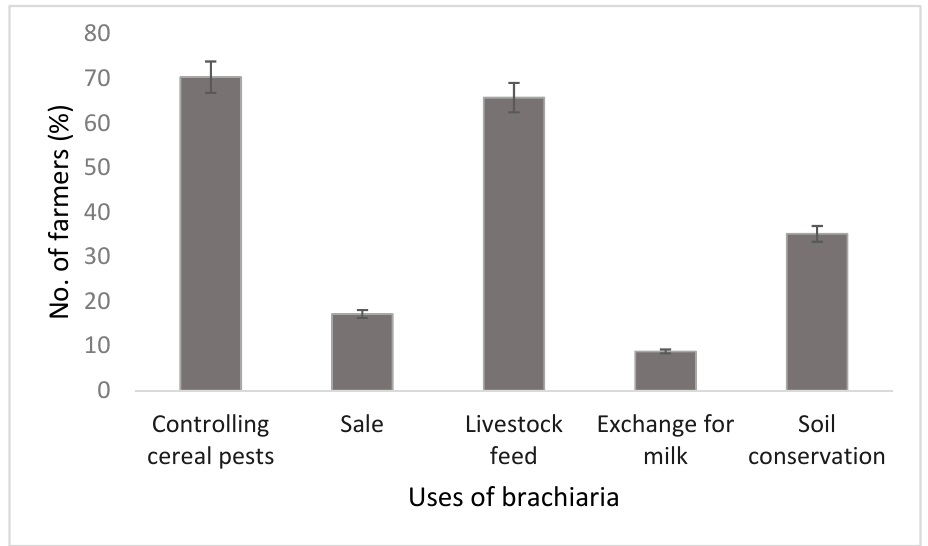
Figure 1. Main uses of brachiaria by the small-holder push pull farmers.